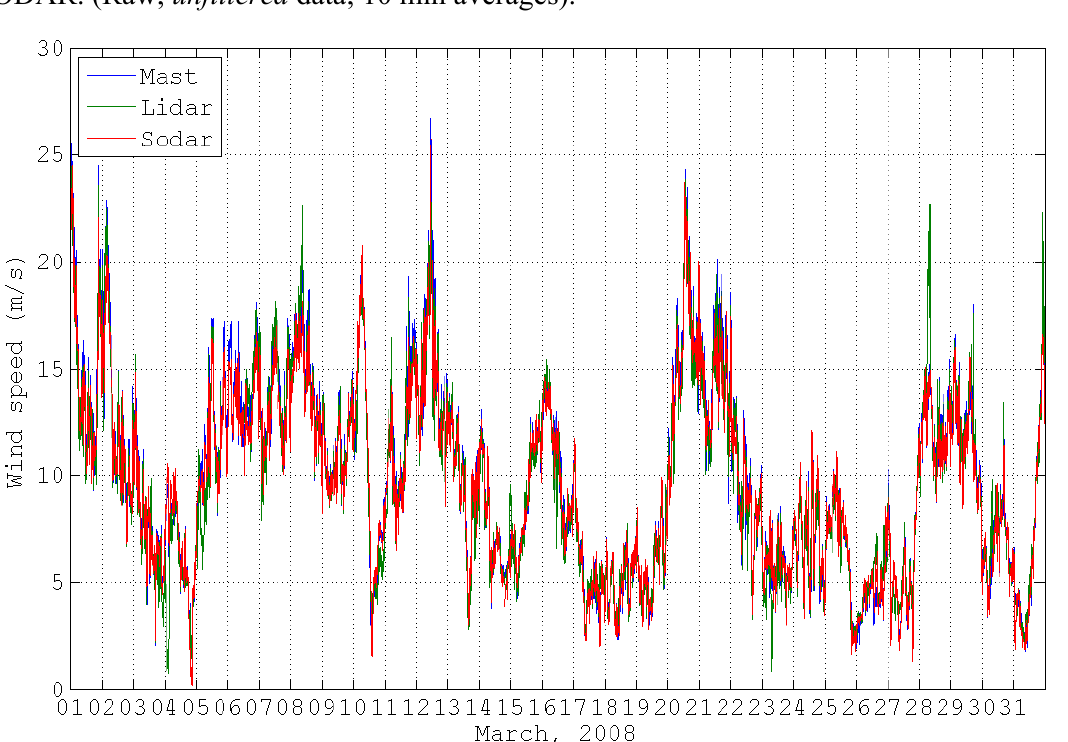
Figure 5. Comparison of 80 m wind speeds from cup anemometer (Mast), LIDAR and SODAR. (Raw, unfiltered data; 10 min